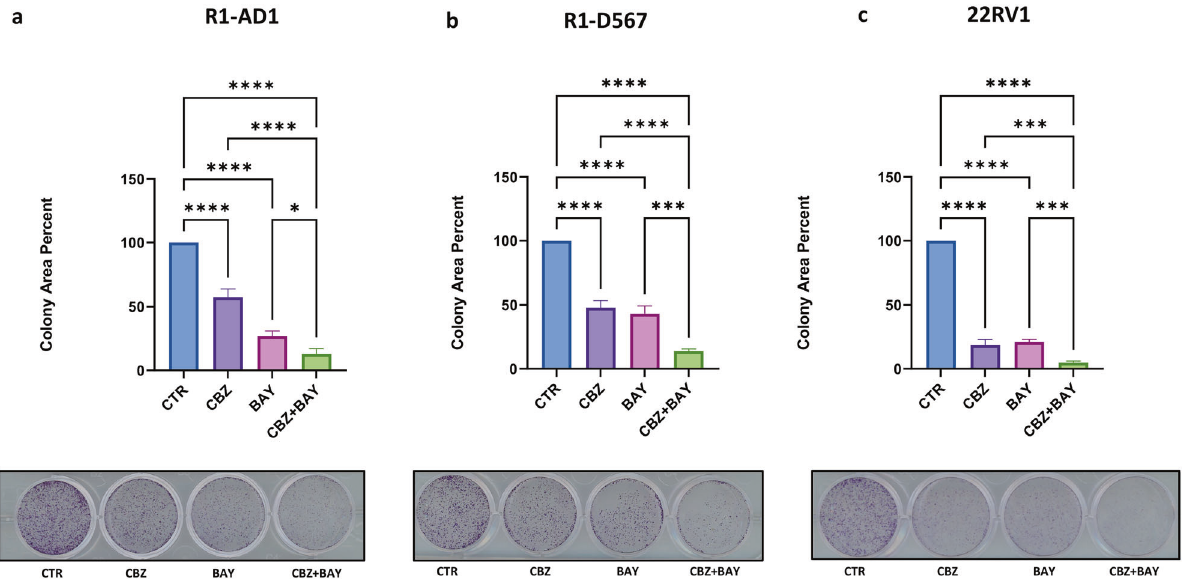
Fig. 4 Mps1i BAY potentiates ef fi cacy of CBZ treatment independent of AR status. Cells: R1-AD1 (AR-FL, a ), R1-D567 (AR-DLBD, b ) and 22Rv1 (AR-FL + AR-DLBD, c ) were treated with CBZ (0.1 nM), BAY (3 nM R1-AD1, 1 nM R1-D567, 4 nM 22RV1) or combination for 24 h in triplicates. Colonies were stained with crystal violet 7 days later. ImageJ was used to calculate the area of the colonies (top); representative images (bottom). Experiments were repeated at least three times in triplicates; representative results are shown. In a – c , columns: mean; error bars: standard deviation. * p < 0.1; ** p < 0.01; *** p < 0.001; **** p <